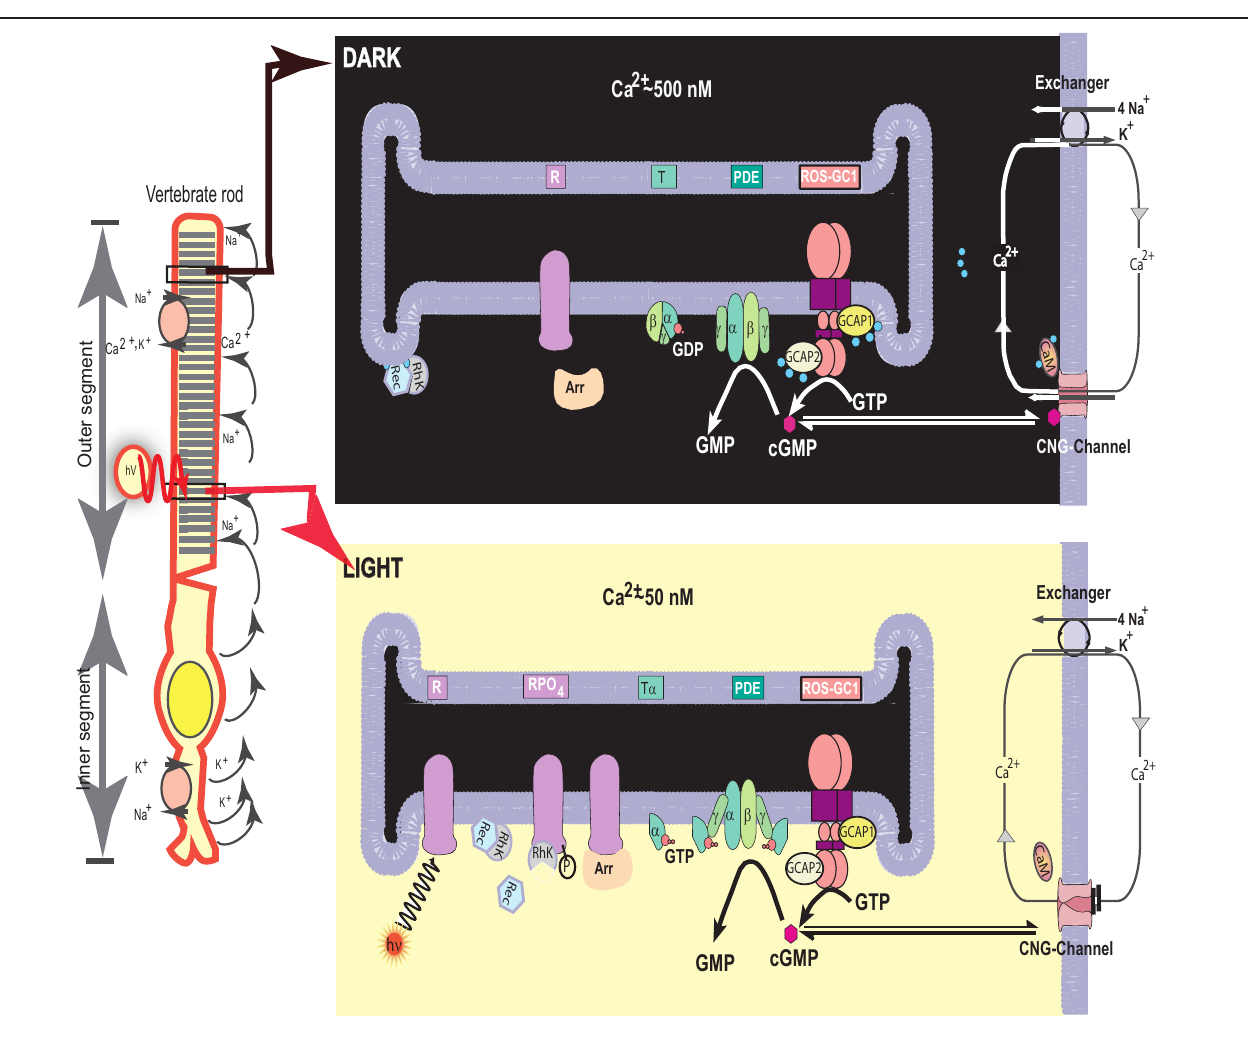
FIGURE 1 | Photo-transduction model. Left panel. An illustration of a typical vertebrate rod. In the dark a circulating current (arrows) is present, which is outward in the inner segment and carried primarily by K + ; in the outer segment the net charge flow is inward, with about 90% of the inward flow carried by Na + and 10% by Ca 2 + ions. Na + /K + exchange pumps in the inner segment membrane and Na + /K + -Ca 2 + exchangers in the outer segment membrane (see also right panels) maintain the overall ionic gradients against the dark flows. The capture of a photon (h ν ) by a rhodopsin molecule in one of the disc membranes of the outer segment initiates the photo-transduction cascade. Right upper panel. The components of the photo-transduction cascade are shown in the dark/resting steady-state. A high concentration of cytoplasmic cGMP keeps a fraction of CNG-channels in the plasma membrane open. Ca 2 + -ions enter the cell via the CNG-channel and are extruded via the Na + /K + , Ca 2 + -exchanger. Synthesis and hydrolysis of cGMP by ROS-GC and PDE occur at a low rate. The heterotrimeric G protein transducin (T) is in its GDP-bound state and is inactive. The